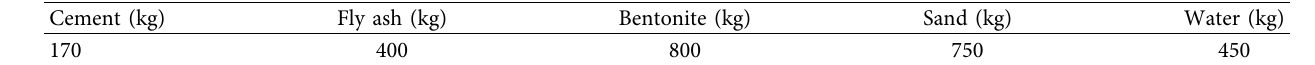
Table 2: Synchronous grouting slurry ratio table.